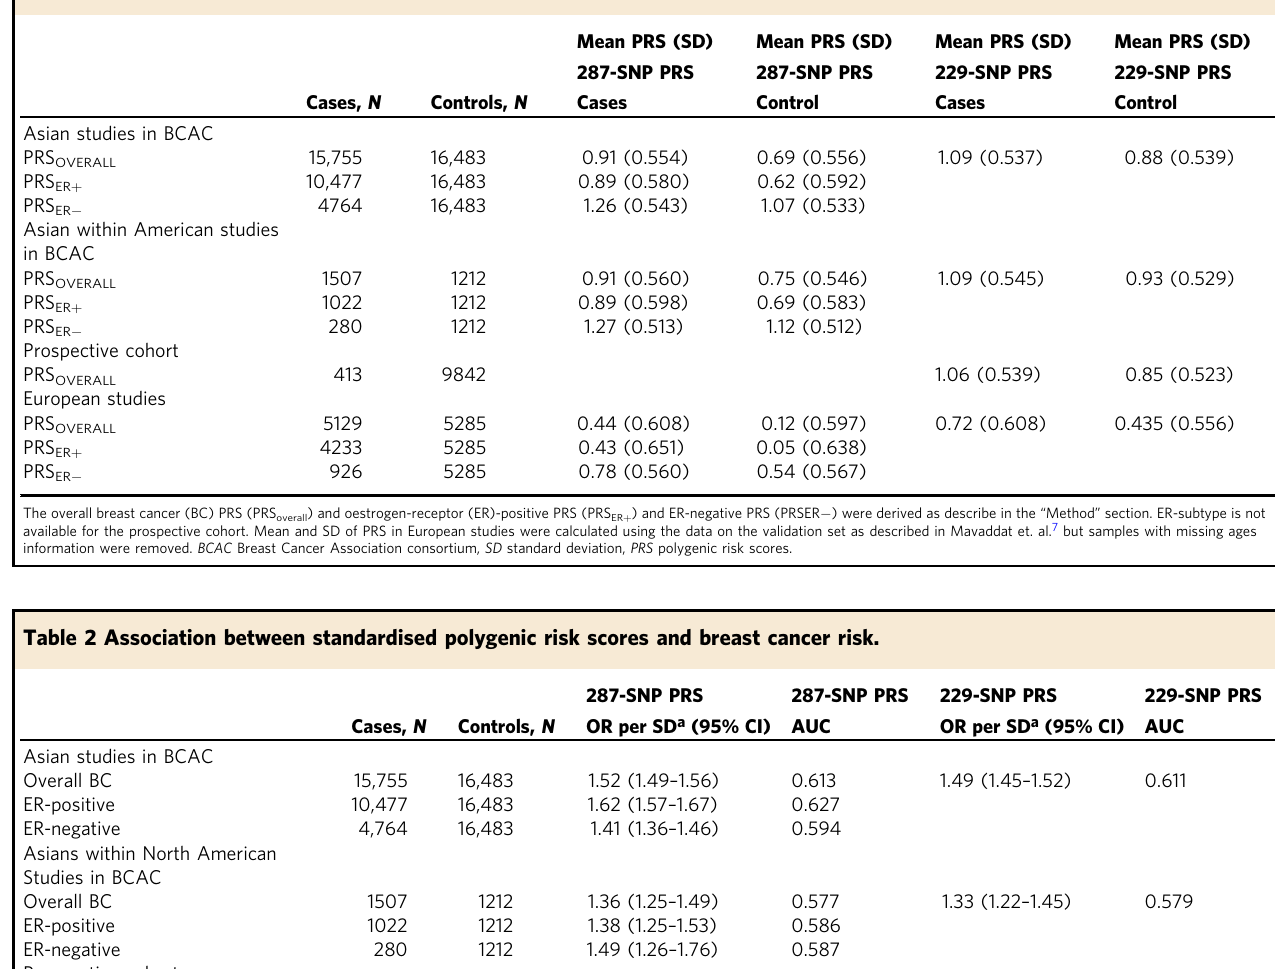
Table 1 Mean and standard deviation of 287-SNP and 229-SNP polygenic risk